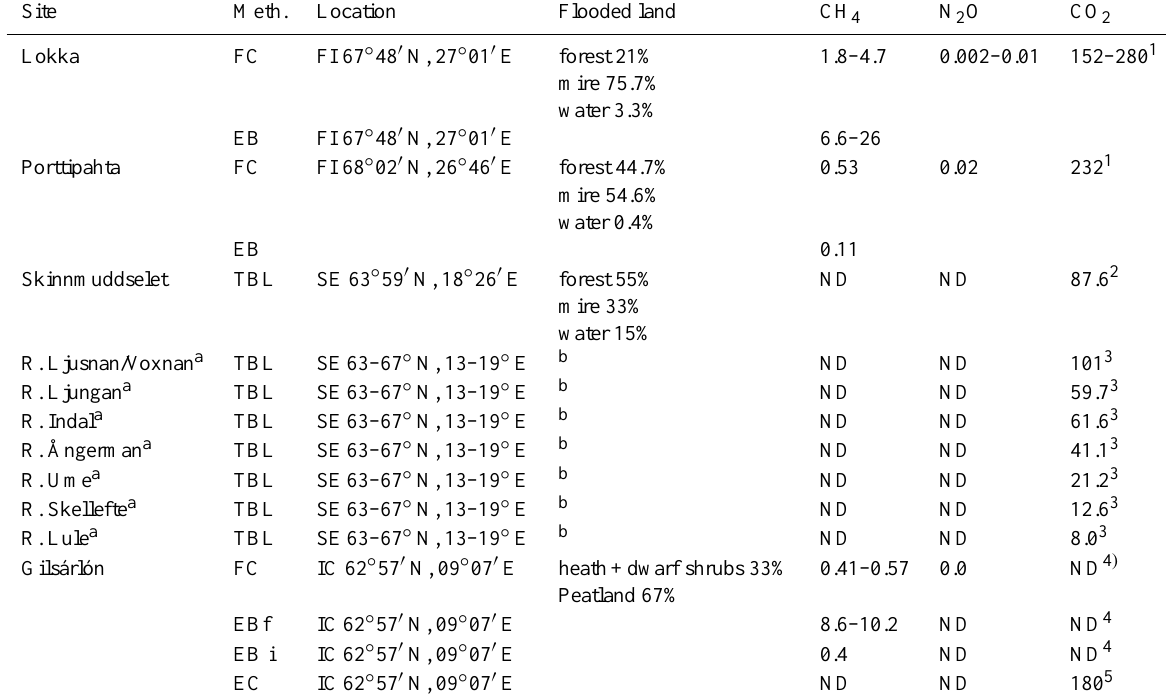
Table 5. Gross GHG emissions (gm − 2 yr − 1 ) from hydroelectric reservoirs in the Nordic countries (FI=Finland, SE=Sweden, IC=Iceland). Methods are FC=gas sampling of floating chamber+GC analyses; EB=recording of ebullition by bubble traps+GC analyses (EBf=ice free, EBi=ice); TBL=water sampling for p CO 2 and the flux calculation by the TBL method. Only the GHG fluxes during open-water season are presented